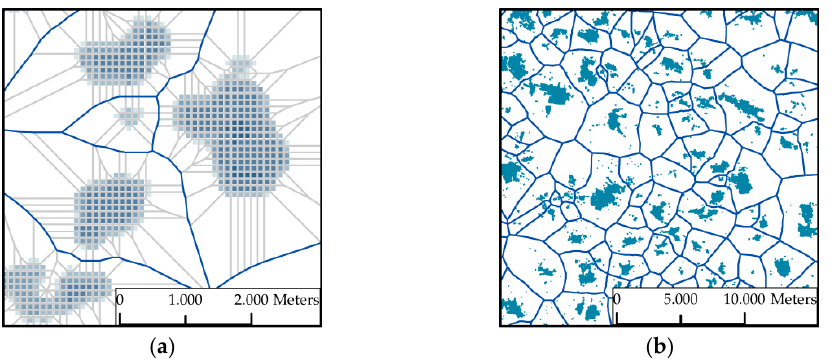
Figure 2. Cartographic partitioning process: ( a ) Voronoi diagram (grey lines) and the remaining meshes (dark blue lines) in the density map; and ( b ) original buildings (turquoise) and boundaries of the final cartographic partitions (dark blue lines).